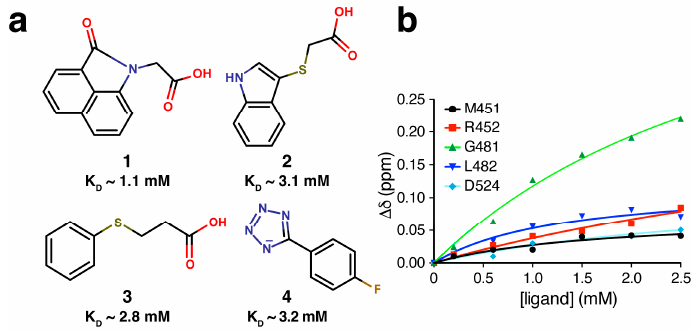
Figure 3. ( a ) Structure of hits with binding affinities for further optimization. ( b ) 15 N– 1 H HSQC titration of fragment 4 . Binding affinities ( K D values) were derived from the change in chemical shift, Δδ , with incremental additions of ligand.